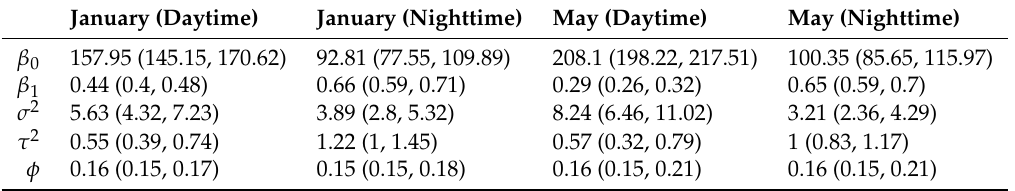
Table 3. Posterior parameter percentiles 50 ( 2.5,97.5 ) of fitted models in January and May of